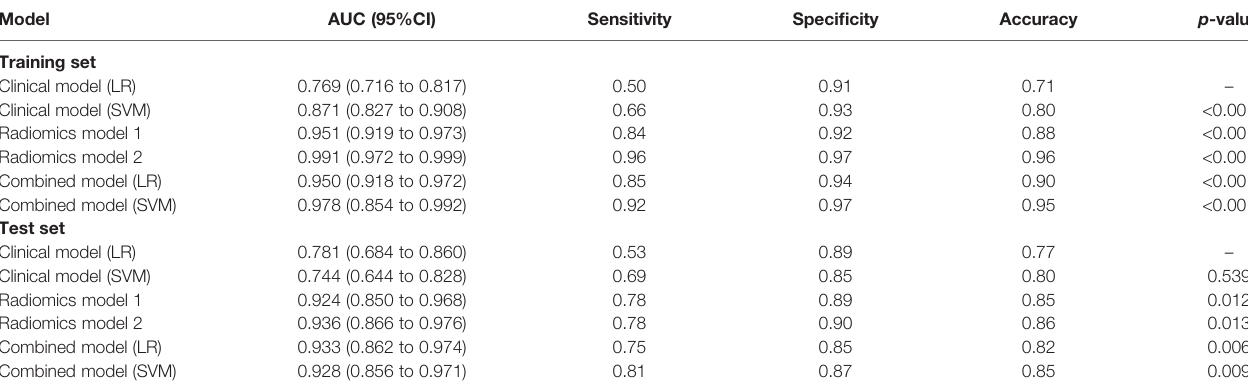
TABLE 2 | Diagnostic performance of the clinical, radiomics, and combined models.